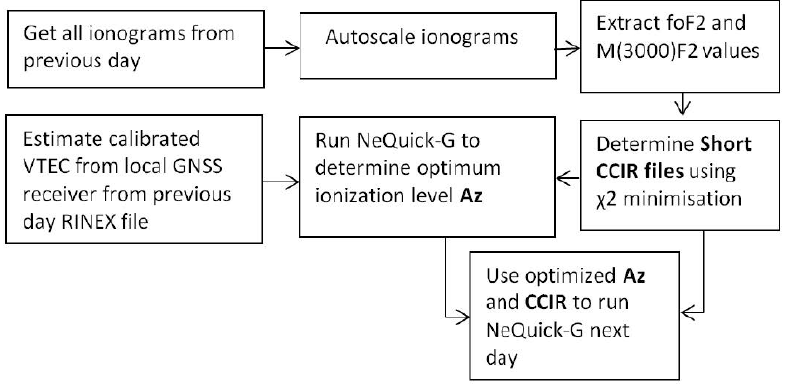
Figure 8. Diagram illustrating the Short-term improvement service.